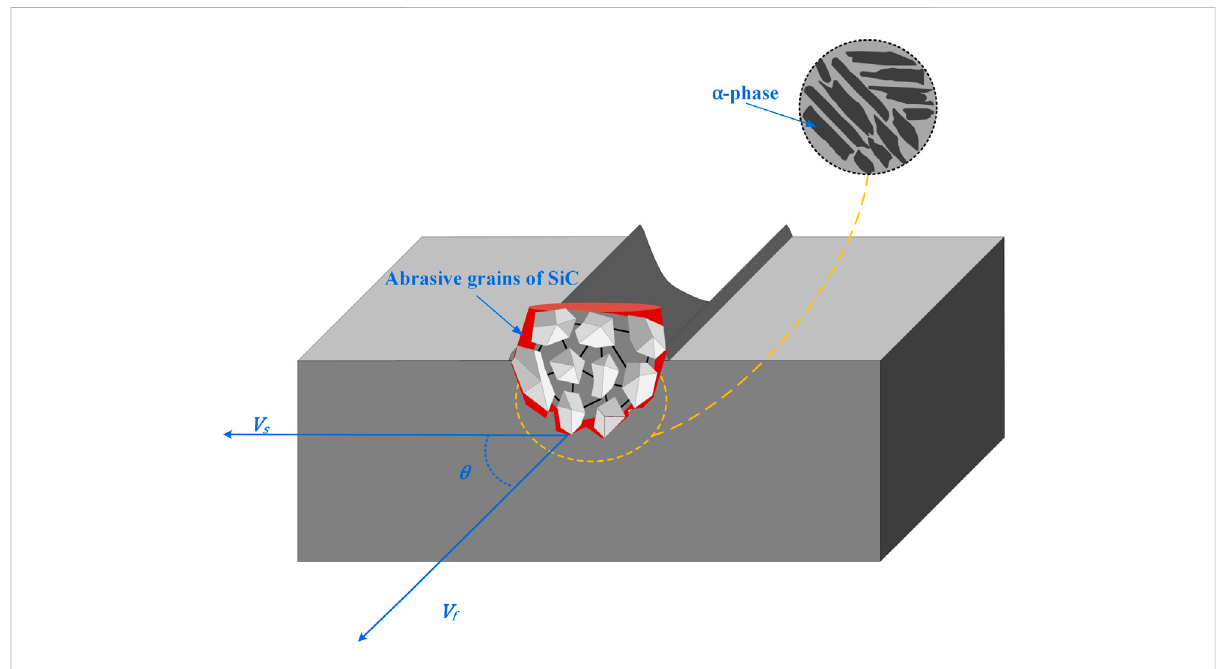
FIGURE 3 Grinding mechanism at grinding angle θ